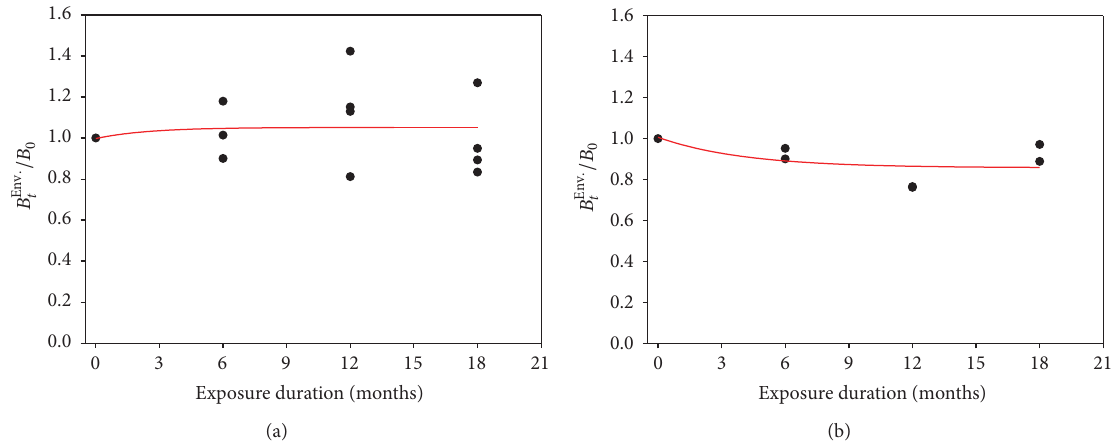
Figure 10: (a) Effect of exposure duration on the normalized 𝐵 for wet-layup FRP system. 𝐵 Env . 𝑡 = 𝐵 0 (1.05−0.05𝑒 −0.40𝑡 ) . (b) Effect of exposure duration on the normalized 𝐵 for prefabricated FRP system. 𝐵 Env . 𝑡 = 𝐵 0 (0.85 + 0.15𝑒 −0.25𝑡 ) .